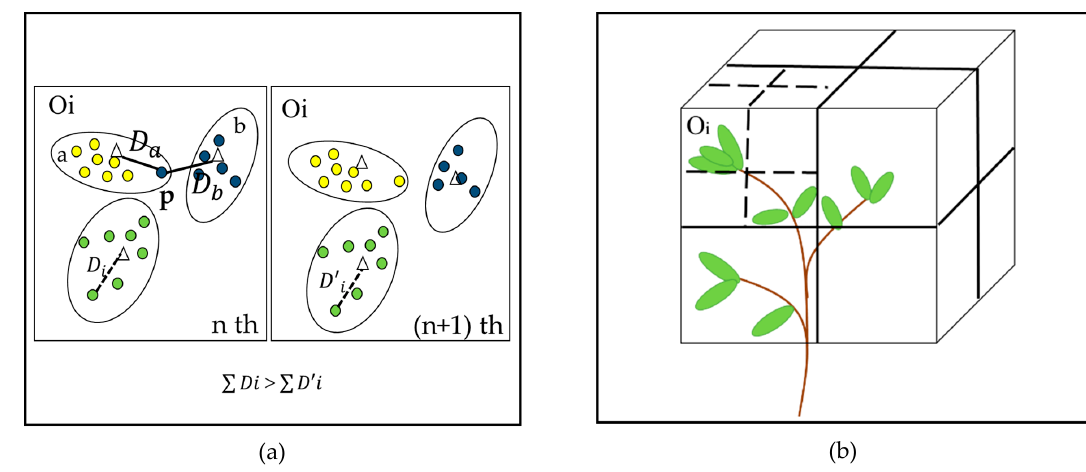
Figure 3. The algorithm for leaf segmentation: ( a ) k -means, where triangles and squares represent the centroid of grouped clusters. The distance from the centroid to the group points is 𝐷𝑖 in the n th iteration and 𝐷 (cid:4593) 𝑖 in the ( n + 1)th iteration. As the sum of ∑𝐷 (cid:4593) 𝑖 becomes minimum, the iteration will stop or the iteration will continue. ( b ) Octree (Oi) is an octree space unit that is divided by octree.